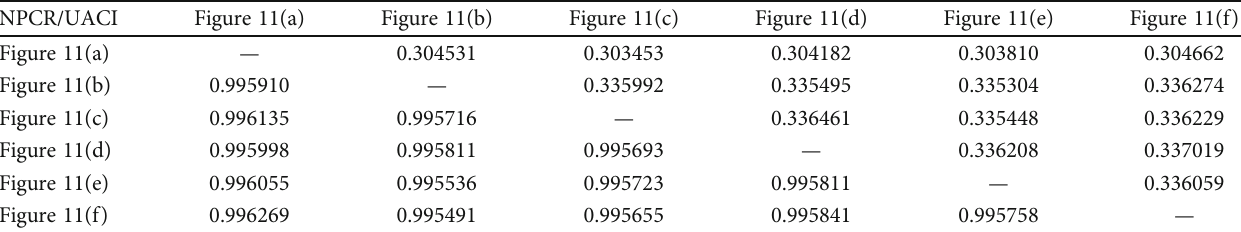
Figure 11: Sensitivity analysis. (a) Decrypted image by correct key. (b) Decrypted image by x image by y = 0 : 85426984531656 + 10 − 15 . (d) Decrypted image by η = 3 : 7 + 10 − 15 . (e) Decrypted image by θ = 5 : 2 + 10 − 15 . (f) Decrypted 0 image by λ = 2 : 6 + 10 − 15 . Table 6: Key sensitivity analysis (%).